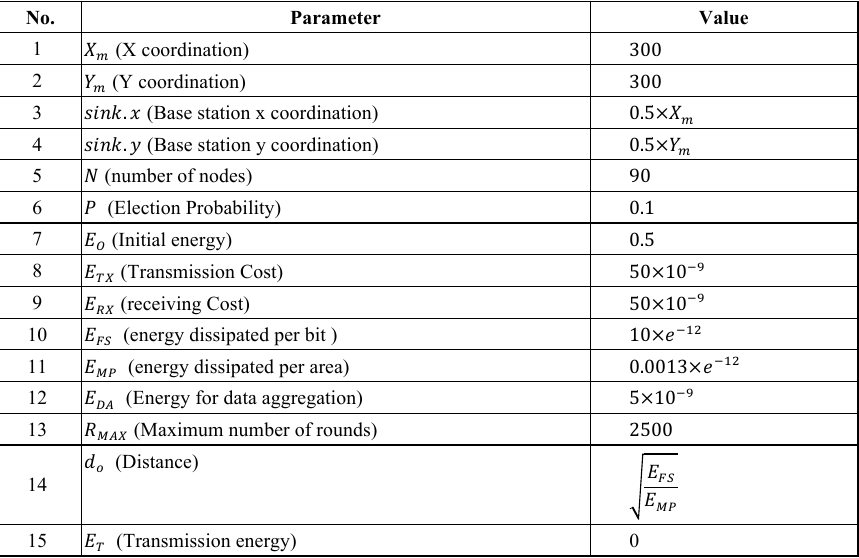
Table 1. The simulation environment parameters